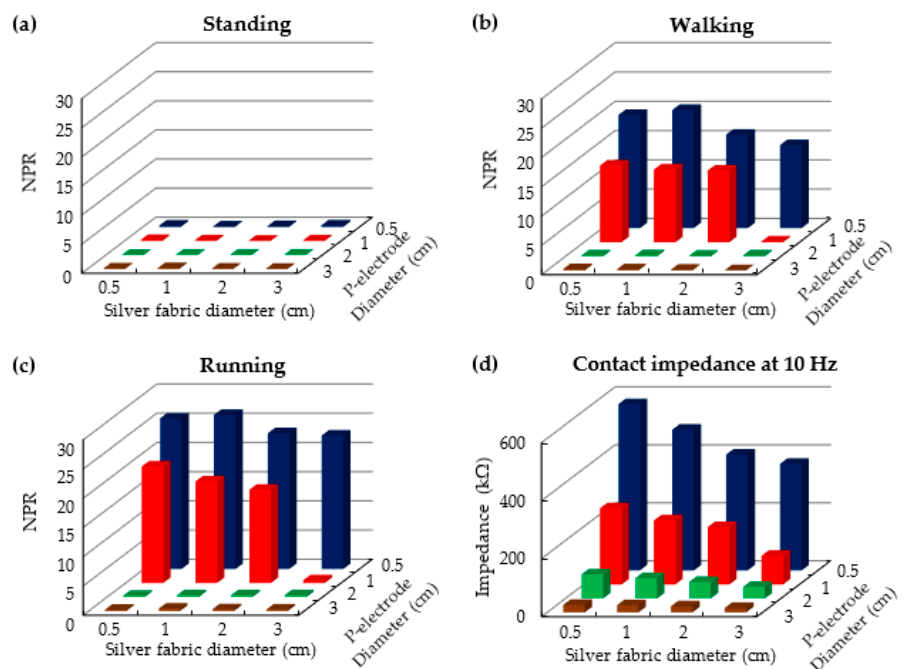
Figure 11. ( a – c ) Noise to P-wave ratio (NPR) in ECG signals obtained during three levels of motion for combinations of P-electrodes on the skin and silver fabric patches on the garment having different diameters; and ( d ) contact impedance measured at 10 Hz for the various combinations of silver fabric patches and P-electrodes.